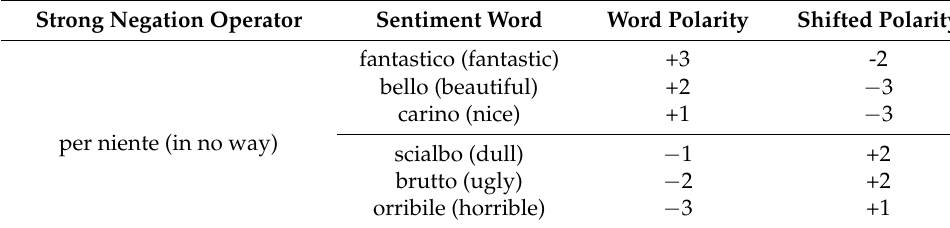
Table 3. Negation rules with strong operators.